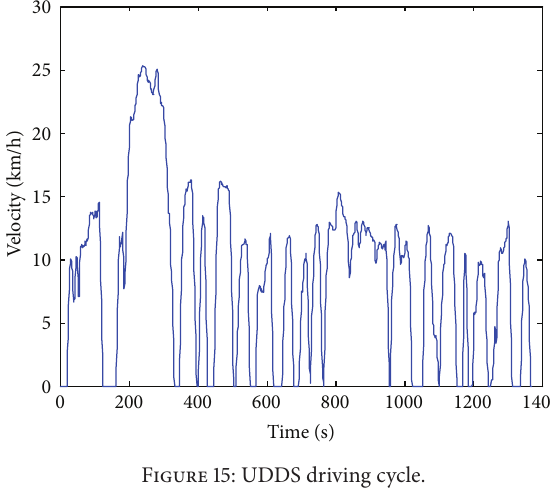
Figure 15: UDDS driving cycle.